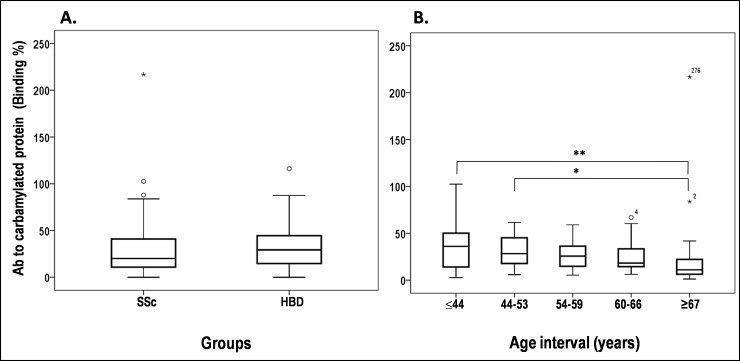
Levels of anti-CarP Ab in SSc patients and healthy blood donors.(A) Sera from 124 SSc patients and 41 healthy blood donors were screened for specificity to CarBSA by indirect ELISA. Binding of anti-CarP Ab is expressed as a percentage of the binding obtained with positive control serum from an RA patient. (B) Anti-CarP Ab levels in SSc patients divided by age at observation into five groups: I, ≤44 years, 32 cases; II, 44–53 years, 28 cases; III, 54–59 years, 24 cases; IV, 60–66 years, 17 cases; and V, ≥67 years, 23 cases. Horizontal bars mark the medians and boxes indicate interquartile ranges; outliers (more than 1.5 times the interquartile range) are marked with circles, while extreme outliers (more than 3 times the interquartile range) are marked with asterisks. Kruskal-Wallis Htest, *p = 0.037, **p = 0.014.